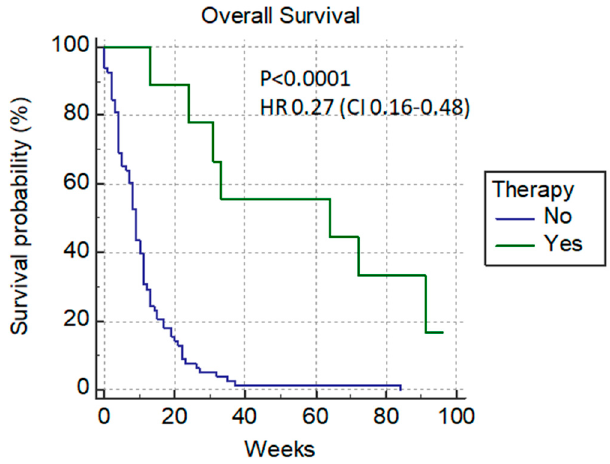
Figure 3. Additional chemotherapy after PTBD.